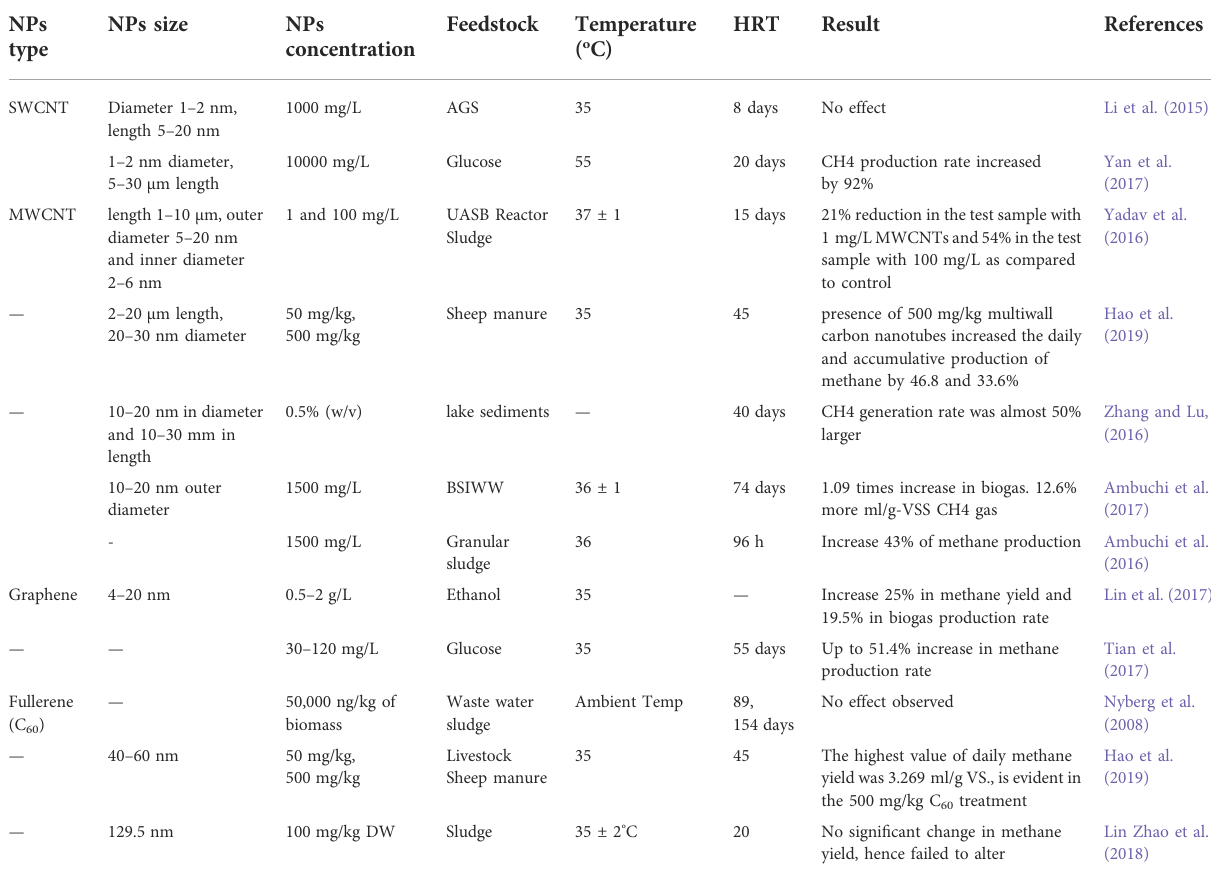
TABLE 6 Reported carbon nanotubes and their in fl uence on biogas